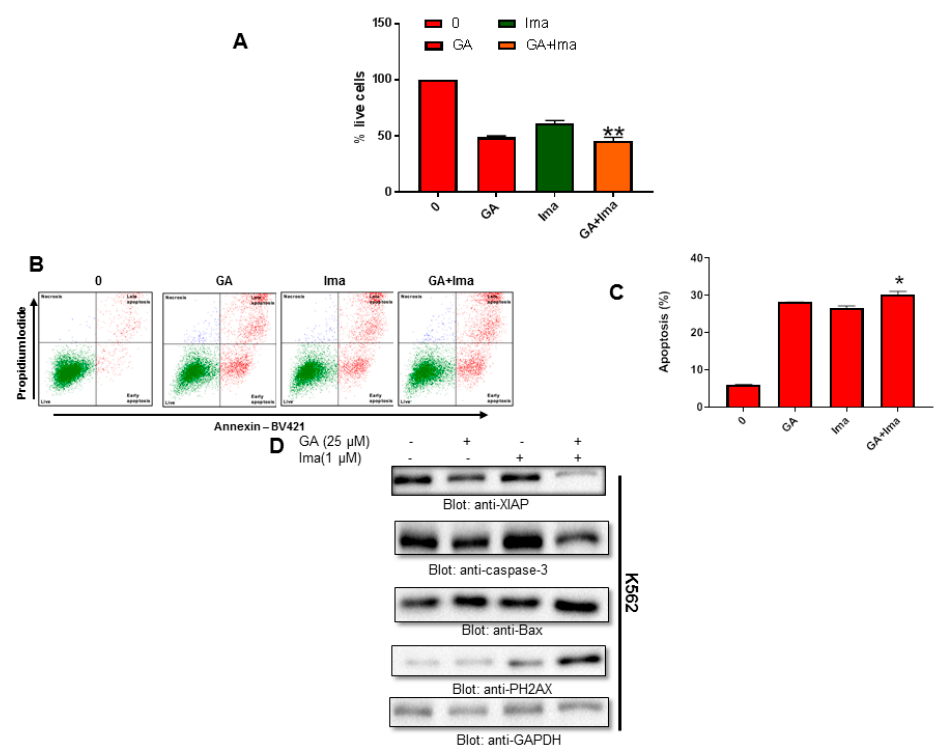
Figure 8. Cytotoxic activity of imatinib and greensporone A in leukemic cell lines. ( A – C ) K562 cells were treated with greensporone A (25 µM) and imatinib (1 µM) alone and in combination, and analyzed for cell proliferation and apoptosis by flow cytometry. The graph displays the mean ± SD of three independent experiments (* P < 0.05, ** P < 0.01 and *** P < 0.001). ( D ) K562 leukemic cells were treated with greensporone A (25 µM) and imatinib (1 µM) for 48 h and lysed cell extracts were separated on SDS-PAGE, transferred to PVDF membrane, and immunoblotted with an antibody against XIAP, procaspase-3, BAX, PH2AX, and GAPDH. Biomolecules 2019 , 9 , x Altogether, our data suggests that greensporone A induced apoptosis in leukemic cell lines via suppression of activated AKT and its downstream targets. In summation, greensporone A also mediated its apoptotic effect through induction of a mitochondrial-mediated pathway. A schematic diagram (Figure 9) illustrates the proposed apoptotic pathway induced by greensporone A in leukemic cell lines.